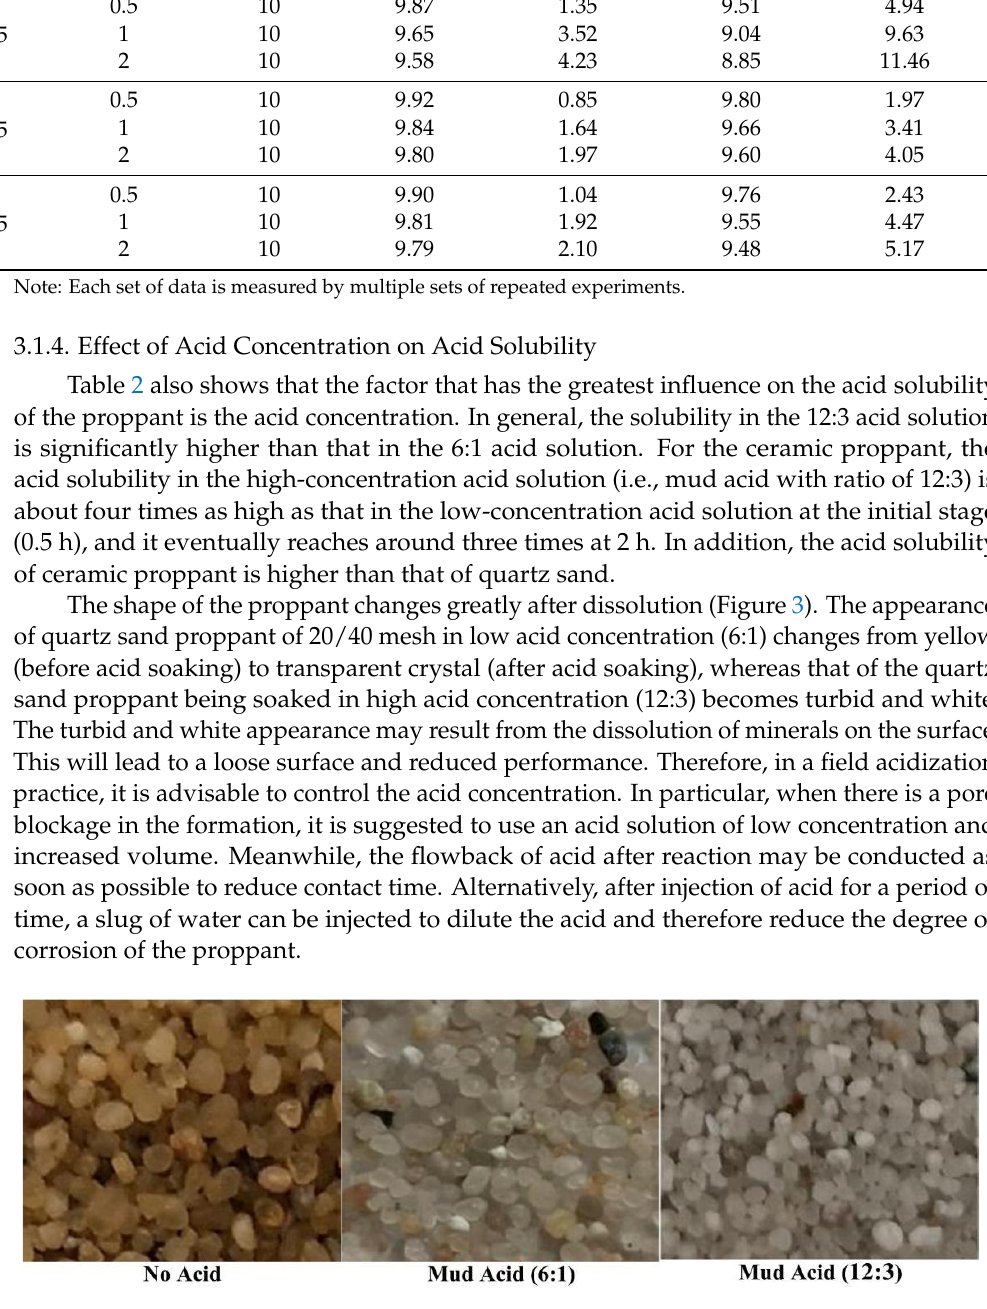
Figure 3. Photomicrograph of proppant after mud acid soaking experiment.